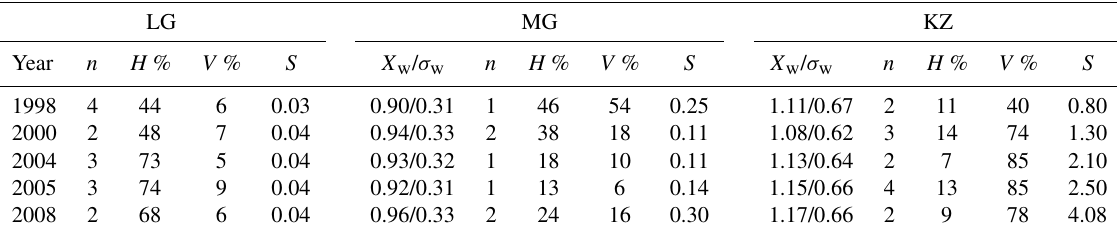
Table 2. Statistics of reach characteristics for individual surveys. Here, n denotes number of reaches in the survey, H % and V % denotes the percentage of the horizontal and vertical distance of the total surveyed channel length by the different reach types. S denotes slope, and X w and σ w represent mean channel width and standard deviation respectively. Note, the channel geometry of KZ reaches often precluded the robust measurement of a meaningful channel